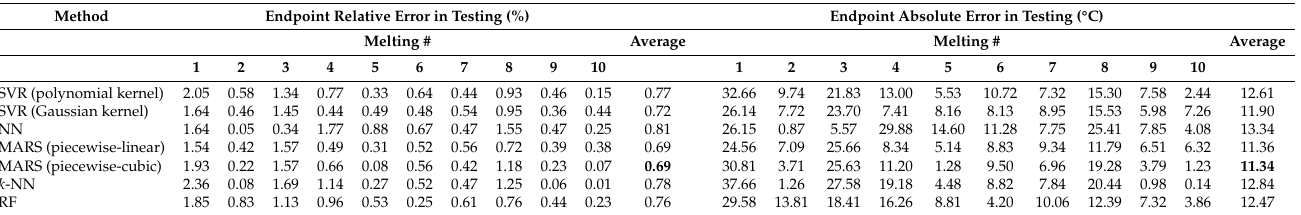
Table 5. Absolute and relative errors on selected meltings in temperature prediction based on static data.